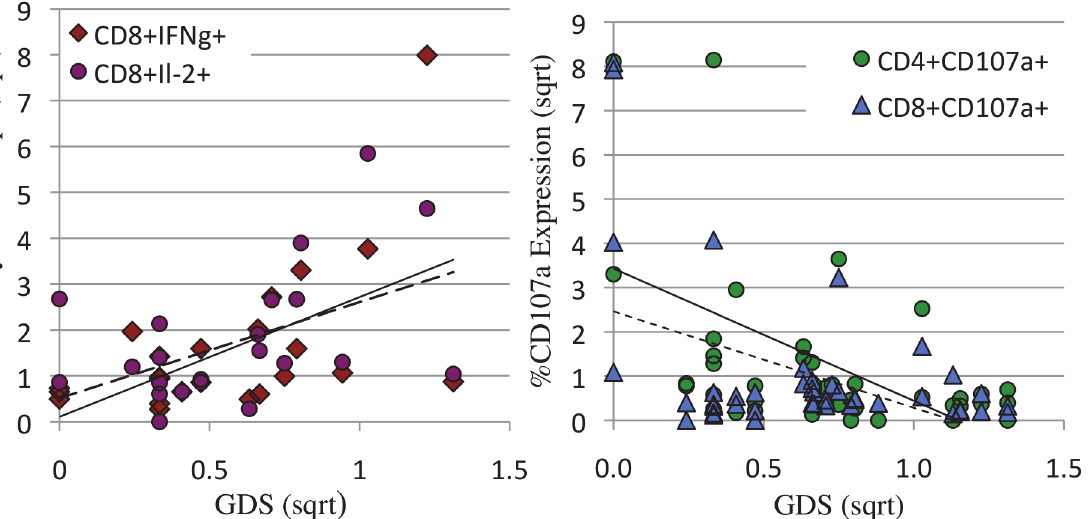
Fig 3. When HIV RNA was detectable in CSF, constitutive CD8+IFN γ and IL-2 expression correlated positively with NCI (Fig. 3a) and CD4+ and CD8 +CD107a expression correlated negatively with NCI (3b) Percent cytokine (3a) or lytic marker (3b) expression were plotted as a function of neurocognitive global deficit score (GDS). Expression levels and GDS were square root transformed. a : When HIV RNA was detectable in CSF, there was a positive correlation between constitutive CSF CD8+IFN γ (solid line, diamonds r = 0.57, p = 0.004) and IL-2 expression (dotted line, circles r = .49, p = 0.01) and NCI. b: In contrast, CSF CD4+CD107a+ (solid line, triangles r = 0.49, p = 0.001) and CD8+CD107a (dotted line, circles r = .44, p = 0.004) expression were negatively associated with